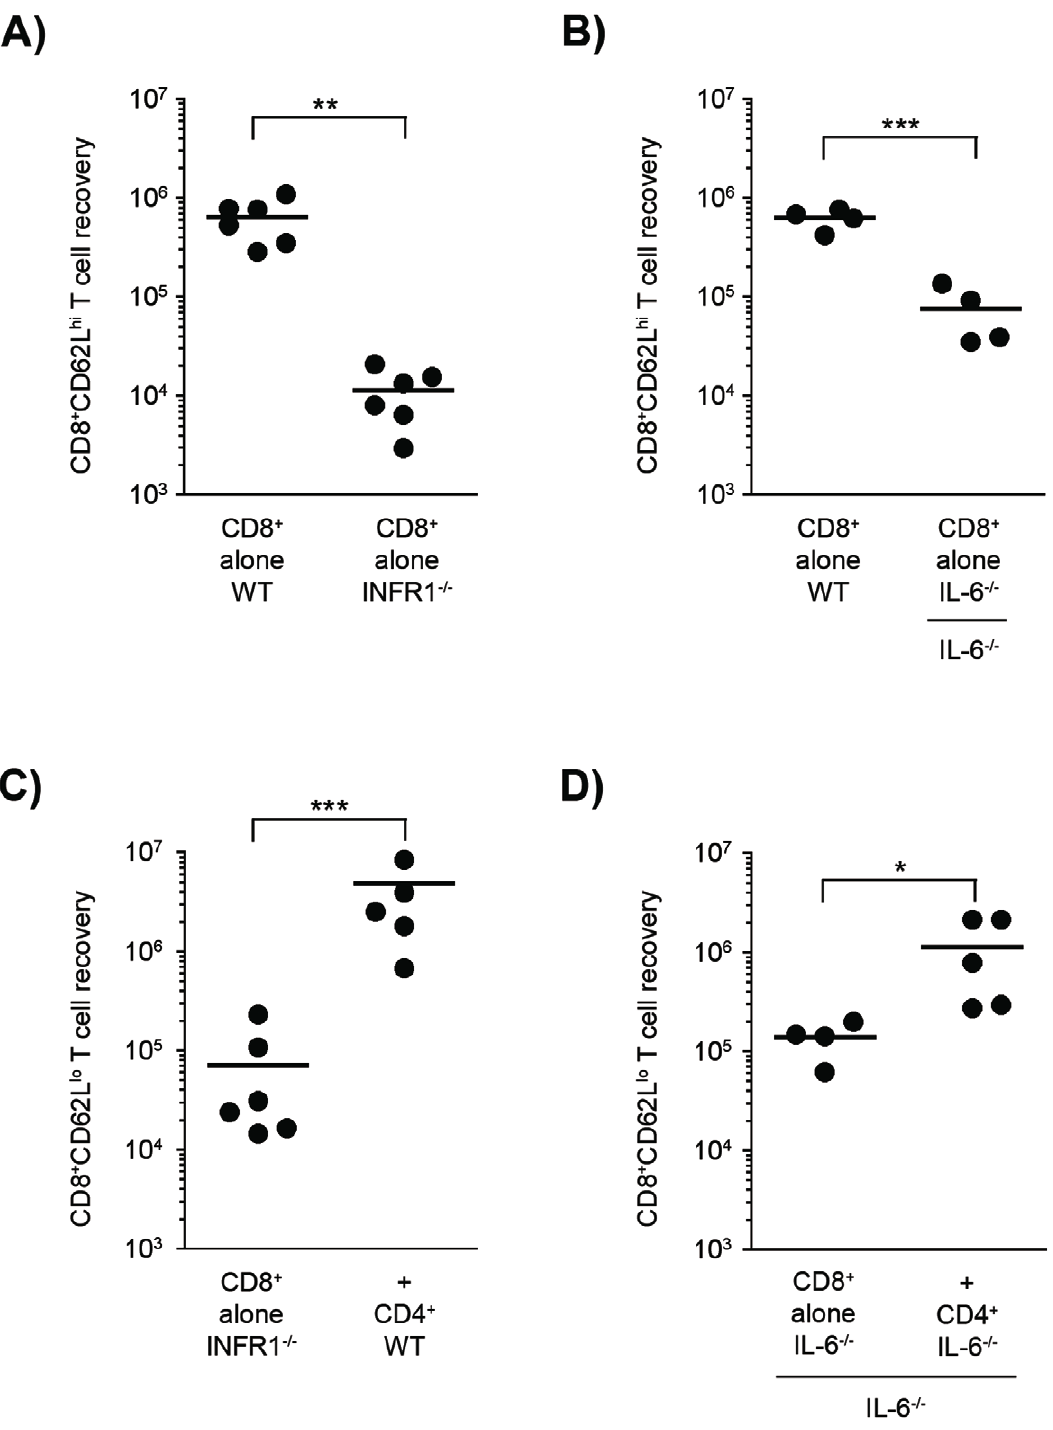
Figure 5. Type I IFN and IL-6 contribute to CD8 + T CM cell recovery. ( A ) 2 6 10 4 CD8 + T cells from WT or IFNAR1 2 / 2 mice were transferred into RAG 2 / 2 mice. The CD8 + CD62L high T CM cell recovery after 7 weeks is shown from two pooled experiments. ( B ) The CD8 + CD62L high T CM cell recovery 8 weeks after the transfer of 2 6 10 4 CD8 + T cells into RAG 2 / 2 or RAG 2 / 2 IL-6 2 / 2 T cell-deficient hosts. ( C ) 2 6 10 4 CD8 + T cells from WT or IFNAR1 2 / 2 mice were transferred alone or with CD4 + T cells into RAG 2 / 2 mice. The CD8 + CD62L low T cell recovery after 7 weeks is shown for two pooled experiments. The absence of IFNAR1 expression doesn’t prevent the CD8 + T cells to receive CD4-help. ( D ) The CD8 + CD62L low T cell recovery 8 weeks after 2 6 10 4 CD8 + T cells from IL-6 2 / 2 mice were transferred alone or with CD4 + T cells into RAG 2 / 2 IL-6 2 / 2 mice. Statistically significant differences are shown (* p # 0.05; ** p , 0.01; *** p , 0.001).